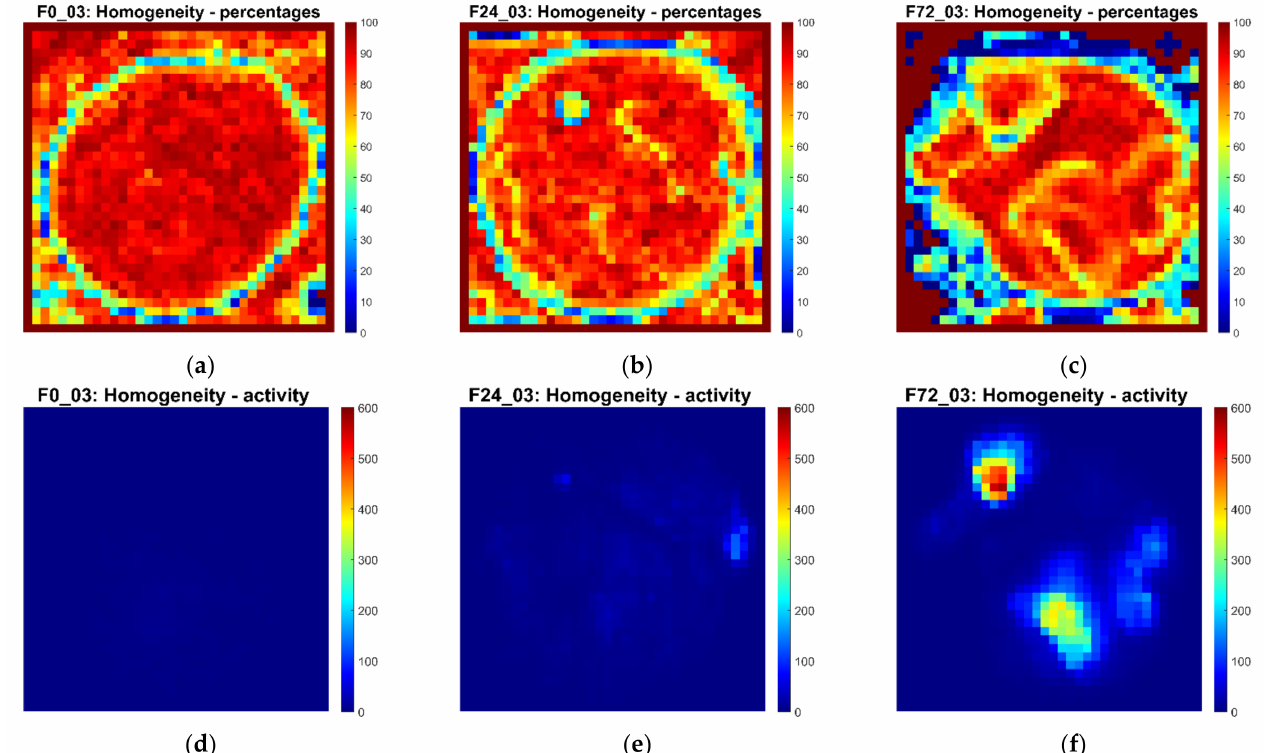
Figure 5. Example maps of homogeneity percentage ( a – c ) and spatial variability of inertia moment ( d – f ) calculated for a frame of 5 × 5 pixels. Maps from left to right present stages F0 (not infested sample), F24 (24 h after exposure), and F72 (72 h after exposure) of example fruit No. 03. Dark blue and red colours correspond respectively to the lowest and the highest values